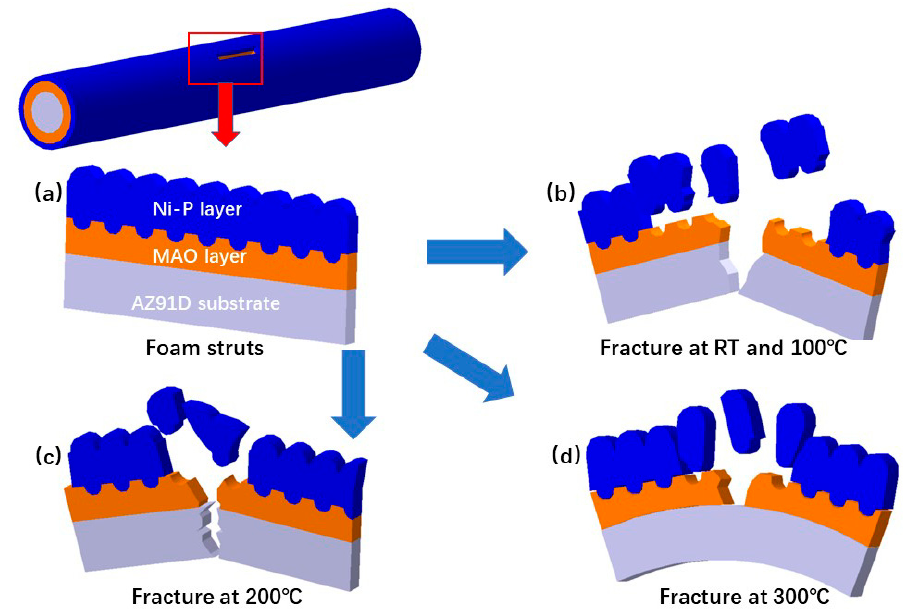
Figure 12. Schematic diagrams of ( a ) the hybrid foam struts:, ( b ) crack features at 100 °C. ( c ) crack features at 200 °C. ( d ) crack features at 300 °C.